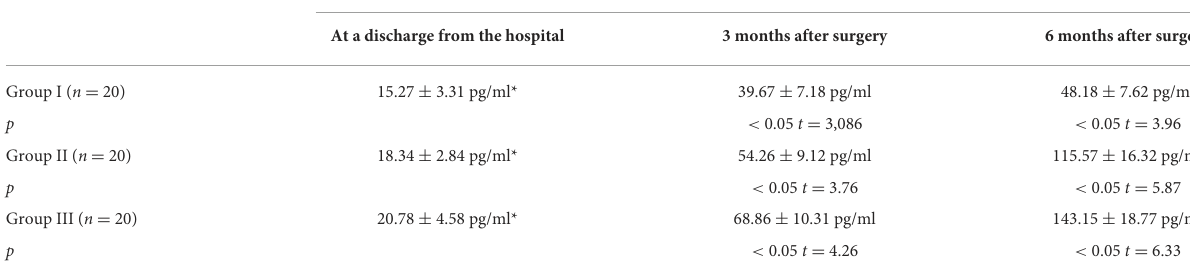
TABLE 5 Changes in TLR4 levels among patients of all groups at different study periods. Serum TLR4